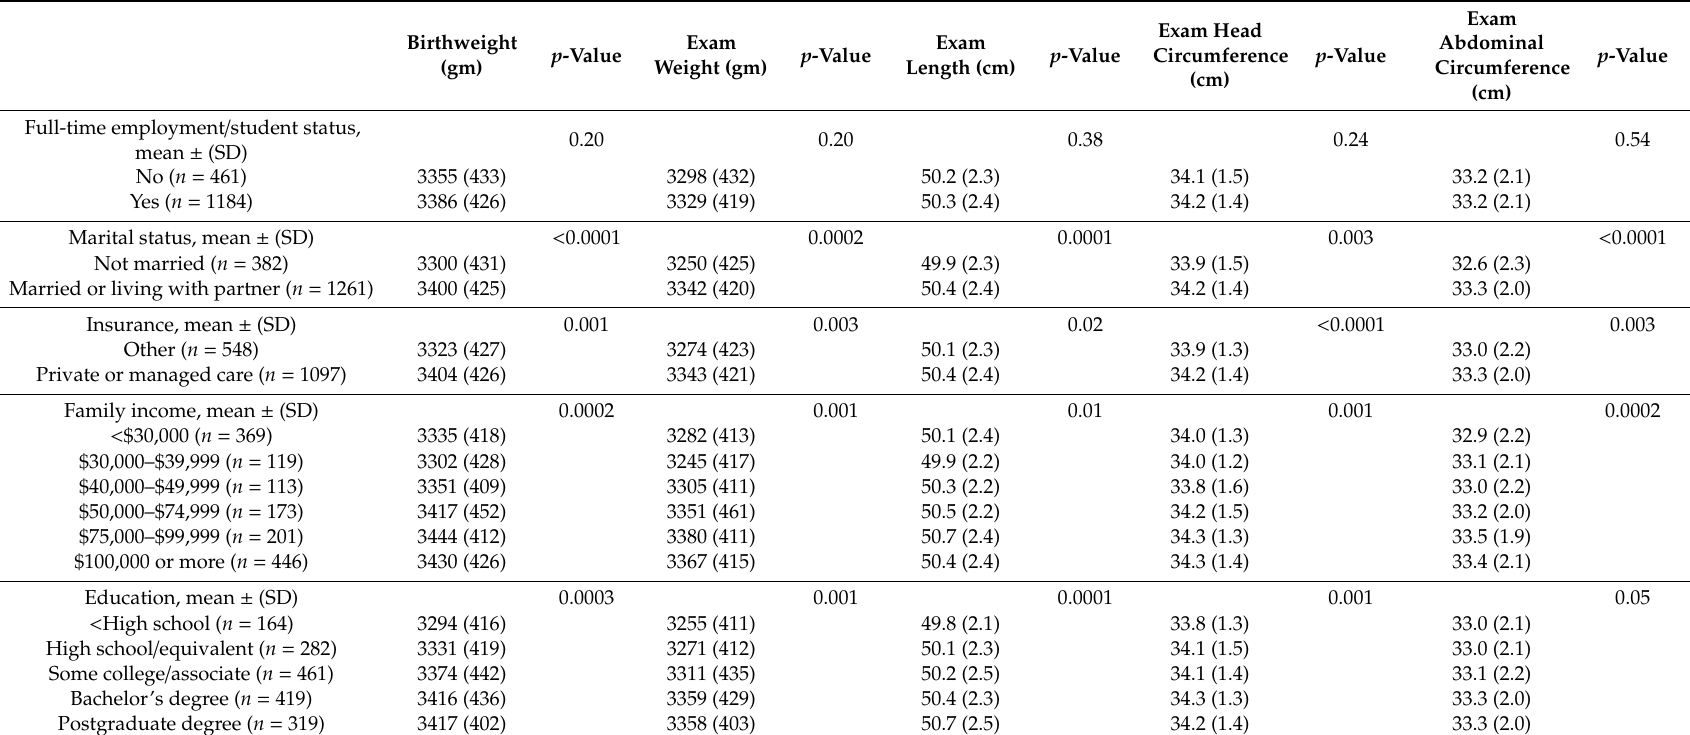
Table 3. Means and SDs for neonatal anthropometric measurements by each category of socioeconomic